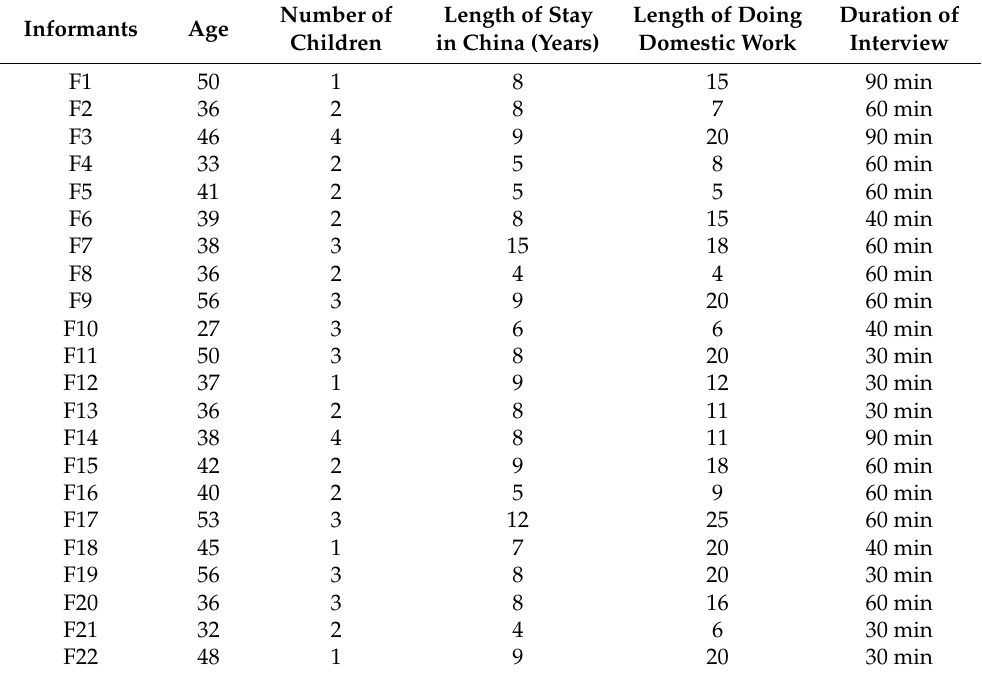
Table 2. Demographic information of informants (N =